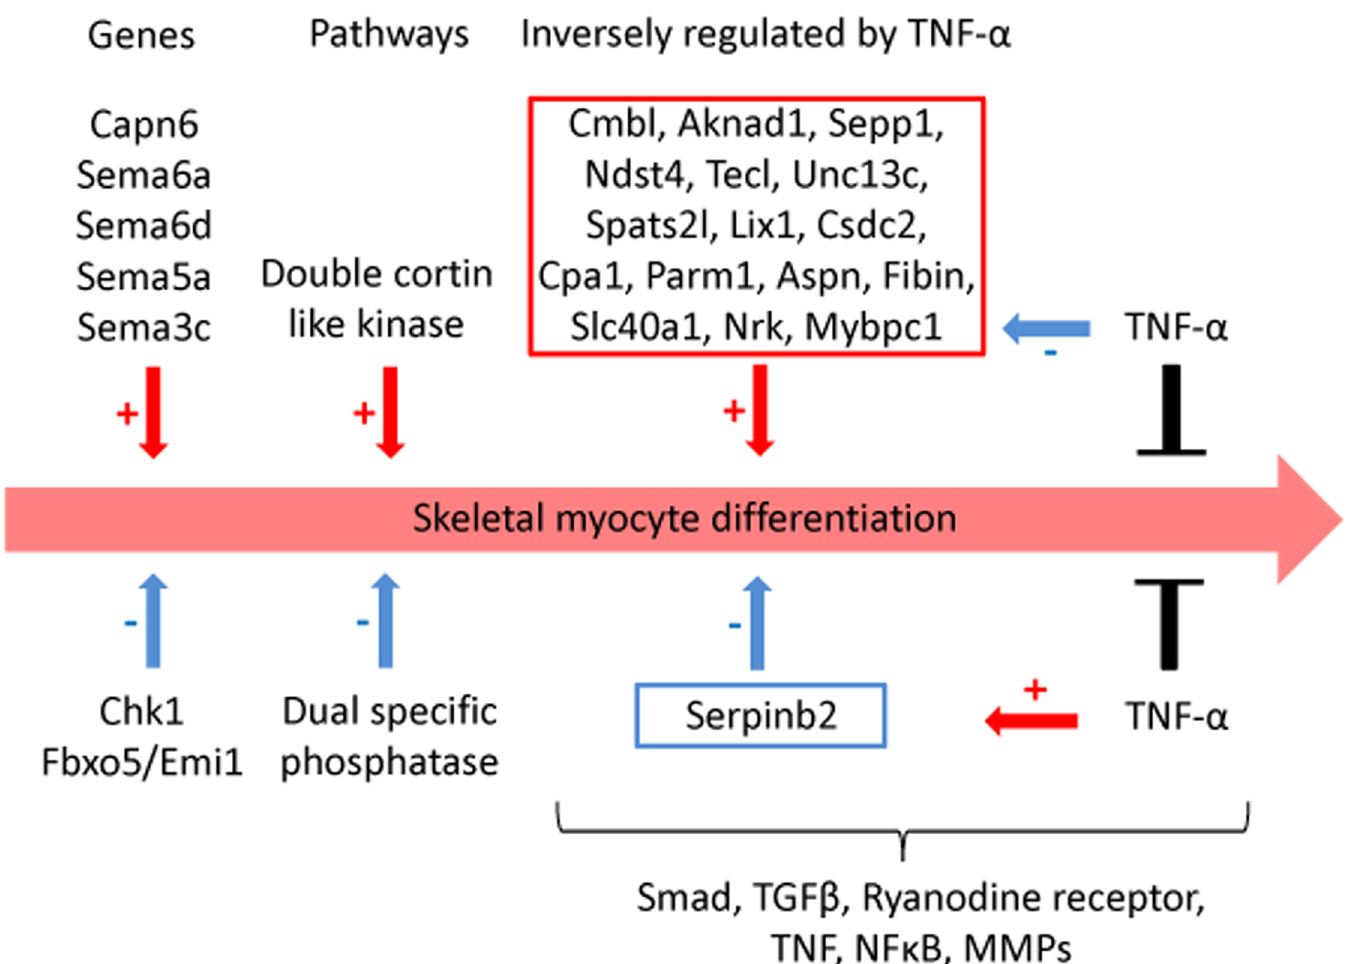
Fig 5. Novel genes and pathways in skeletal myocyte differentiation and TNF- α response. We identified genes and pathway associations, which have not been described before in skeletal myocyte differentiation or have been reported to have a different regulation than the one observed in the current study. A plus indicates upregulation during differentiation and a minus indicates downregulation. Moreover, we show genes which are inversely regulated by TNF- α , but have not been defined before, to be regulated in skeletal myocyte differentiation and response to TNF- α